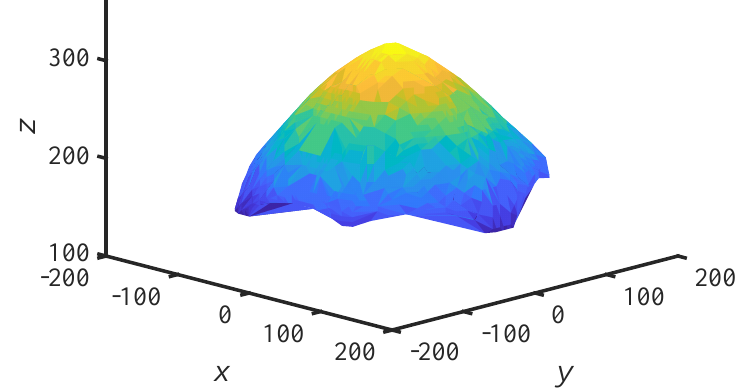
Figure 4. Position workspace of the